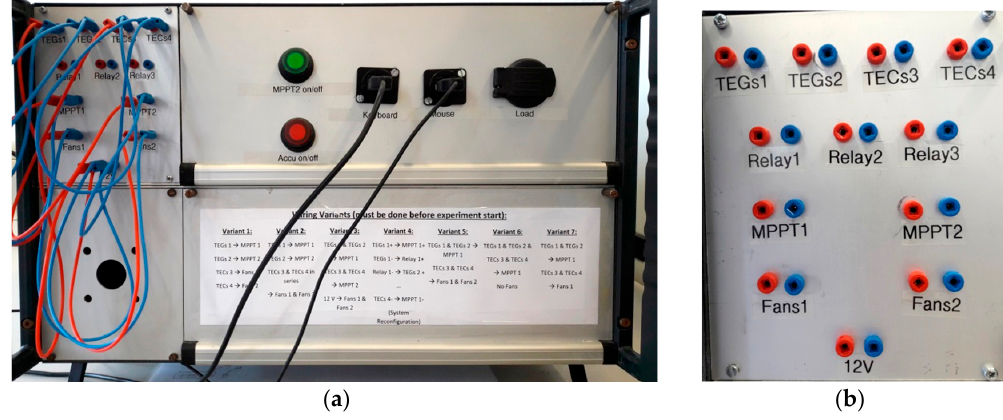
Figure 7. Switch cabinet of the Heating Mockup: ( a ) complete switch cabinet; ( b ) Enlargement of the front panel to realize different wiring structures.